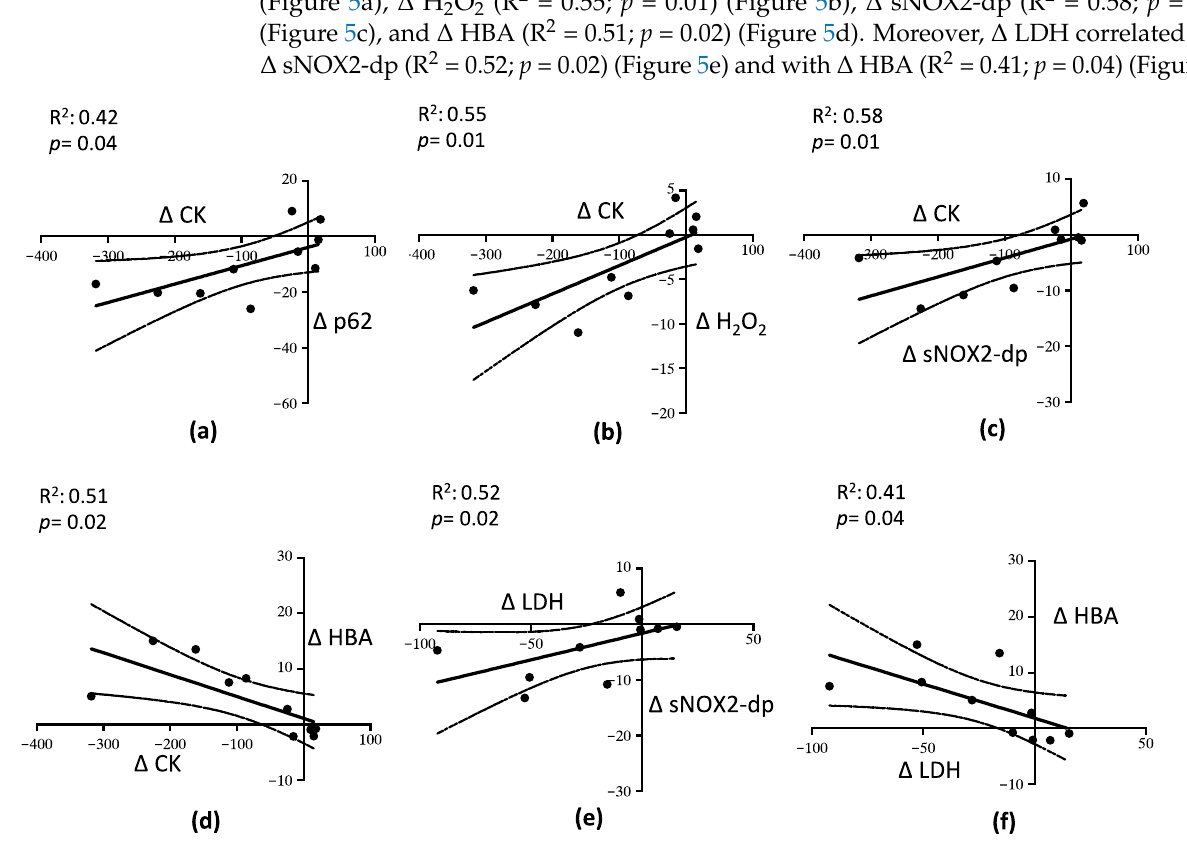
Figure 5. Linear correlation analysis between the parameters describing muscle injury, oxidative stress and autophagy. Relationship between  CK and  p62 ( a ),  CK and  H 2 O 2 ( b ),  CK and  sNOX2-dp ( c ),  CK and  HBA ( d ),  LDH and  sNO2-dp ( e ), and  LDH and  HBA ( f